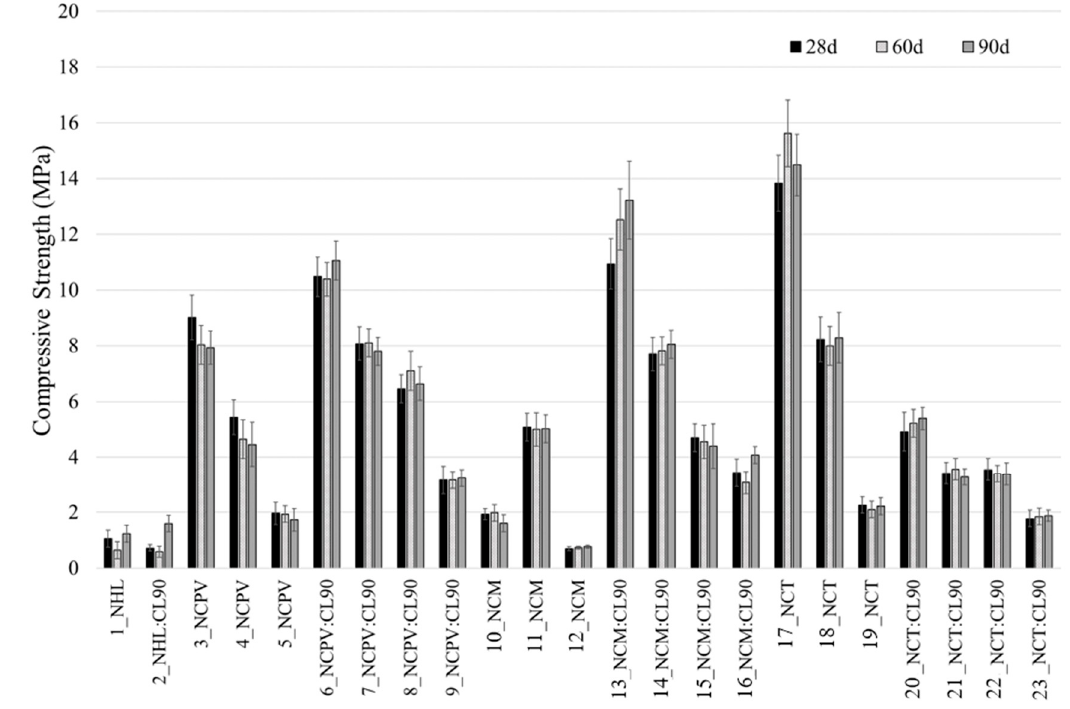
Figure 9. Compressive strength of the mortars.